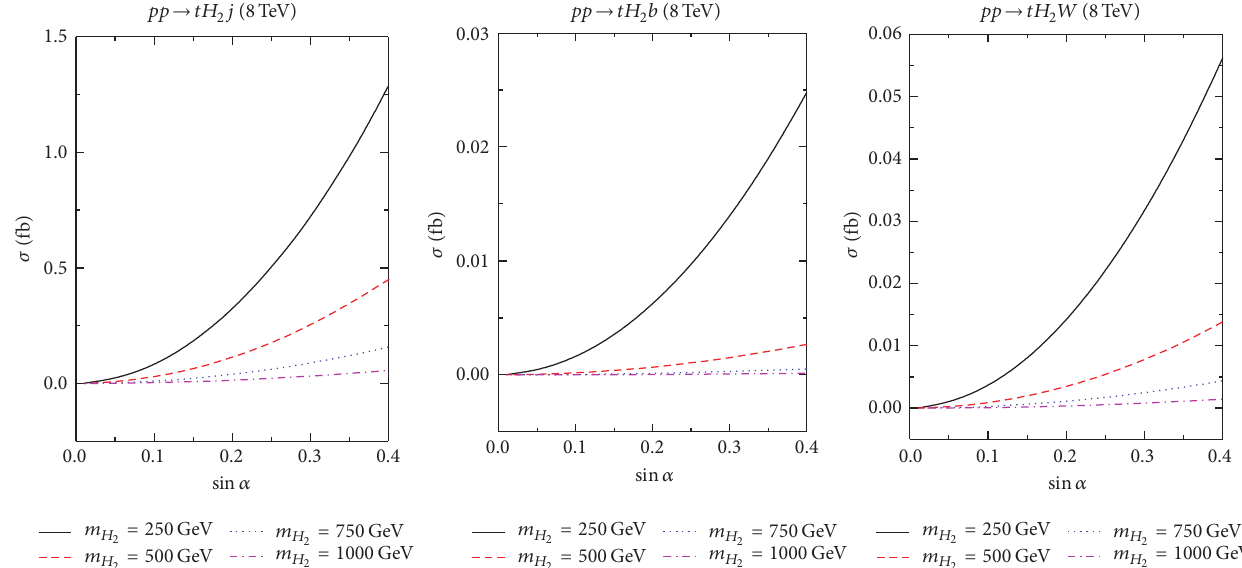
Figure 5: The production cross sections 𝜎 𝑡𝐻